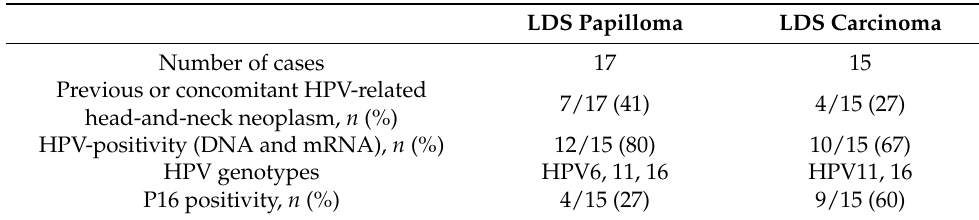
Table 2. Human papillomavirus status of papillomas and carcinomas of the lacrimal drainage system in a Danish cohort. CI, confidence intervals; HPV, human papillomavirus; LDS, lacrimal drainage system; NA, not applicable; OR, odds